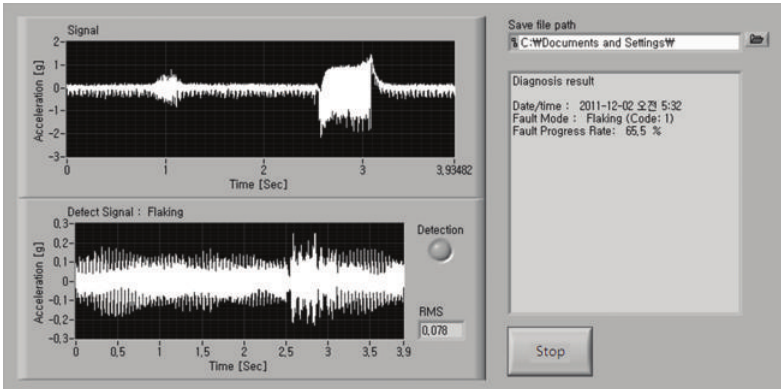
Figure 13: GUI and result of flaking failure